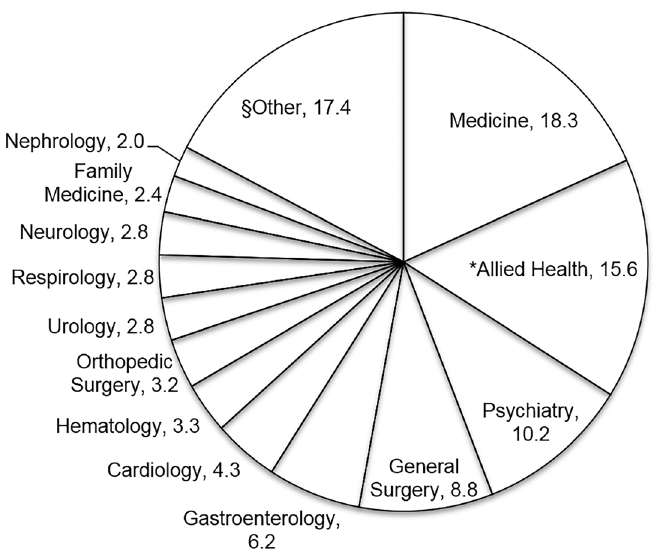
Figure 2. Proportion of consultations for highly frequent users. *Allied Health includes consultations for social work, community care access centre, and geriatric emergency medicine nurses combined. § Other indicates all other services consulted from the emergency department not listed above, and individually <2% of consultations. n=261 patients and 3,164